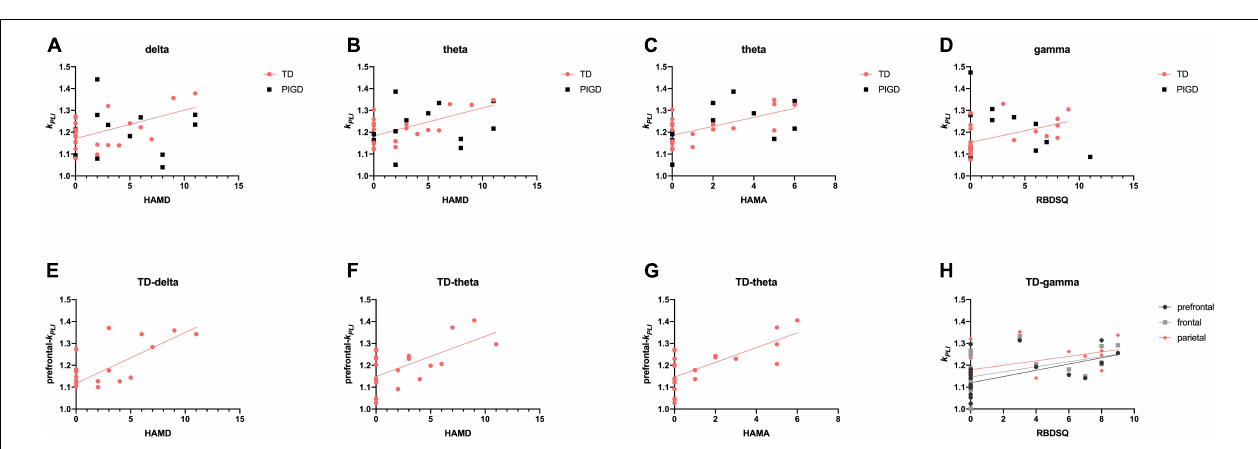
FIGURE 4 | Scatter plot illustrating the correlation between EEG signature and other non-motor symptoms in patients with PD. Upper row: correlations of EEG frequency bands HAMD (A,B) , HAMA (C) , and RBDSQ (D) . Lower row: correlations of EEG characteristic brain regions with HAMD (E,F) , HAMA (G) , and RBDSQ (H) . A significant correlation ( p < 0.05) is marked in solid red, black, and gray lines.